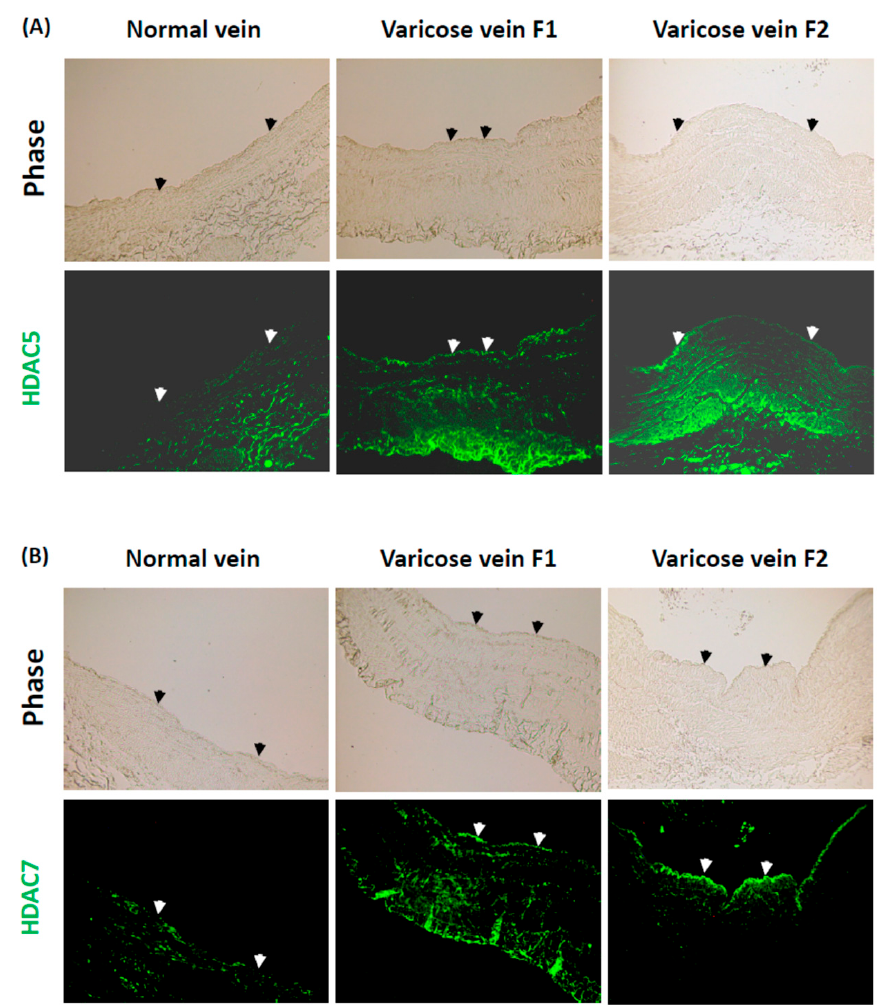
Figure 2. Class II HDACs (HDAC-5 and -7) are up-regulated in the endothelium of human varicose veins with blood reflux but are down-regulated in human normal veins with normal venous flow. Cross-sections of human varicose veins with different levels of blood reflux (varicose vein F1 and F2) and human normal veins with normal venous flow (normal vein) were immunostained for HDAC-5 ( A ) and HDAC-7 ( B ). Arrows represent the endothelia in the blood vessels. All photographs were obtained with fluorescence microscope with a 10 ×